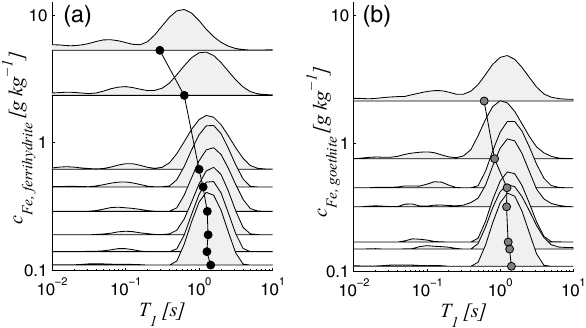
Figure 6. Relaxation time spectra as functions of Fe content for (a) ferrihydrite and (b) goethite samples (Set A); the circles mark the logarithmic mean for each